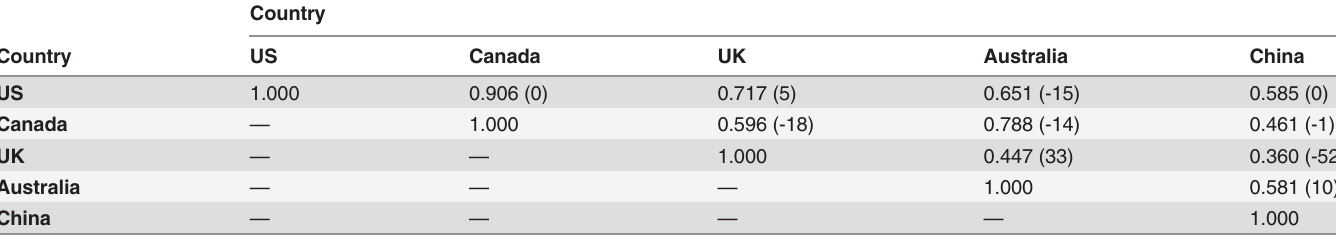
Table 1. The pairwise cross-correlations of seasonal components of tobacco-related search trends.